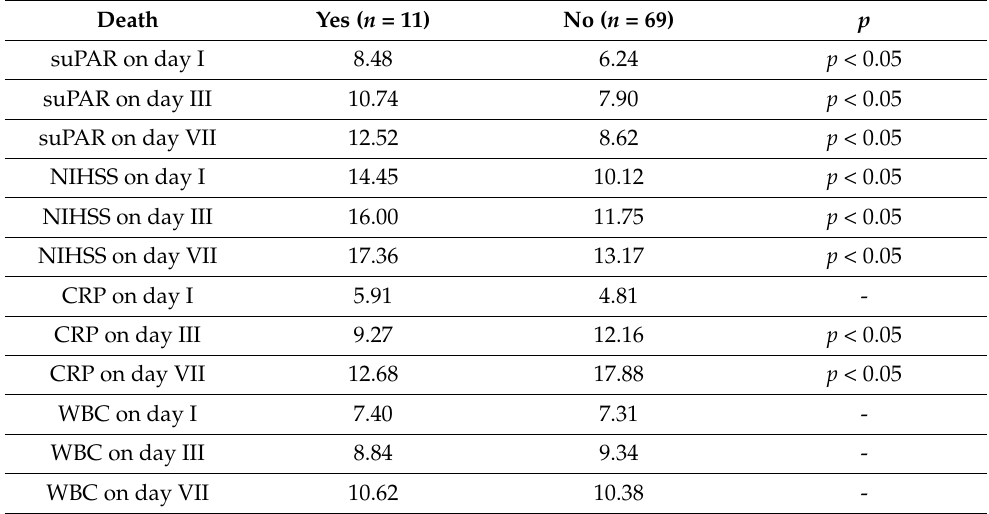
Table 4. Comparison assessed parameters (suPAR, NIHSS, CRP, WBC) and post-stroke mortality.